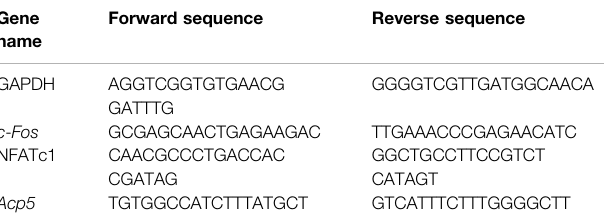
TABLE 1 | Primer sequences used for mRNA transcript